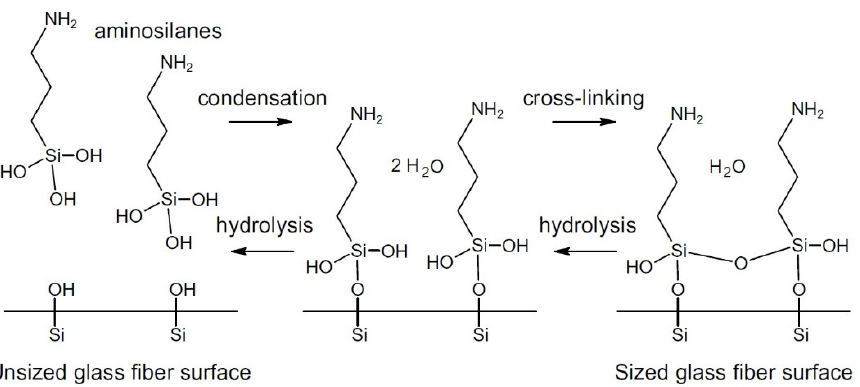
Figure 13. Sizing of glass fibers with aminosilane coupling agents. Reprinted from Reference [44], under open-access license.